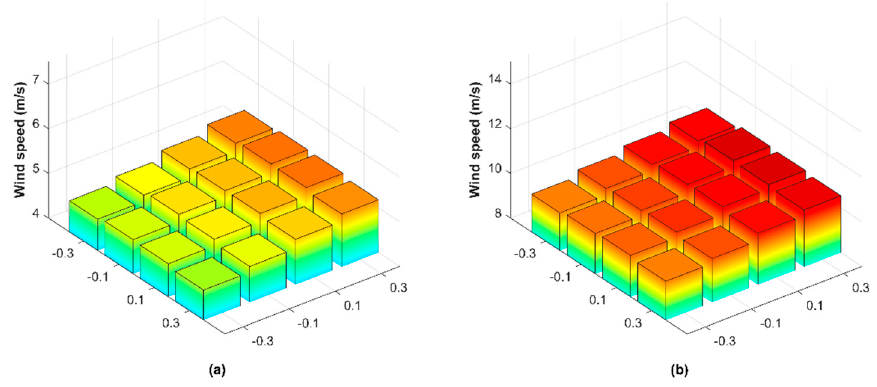
Figure 9. ( a ) measured wind speeds of 5 m/s; and ( b ) measured wind speeds of 5 m/s.